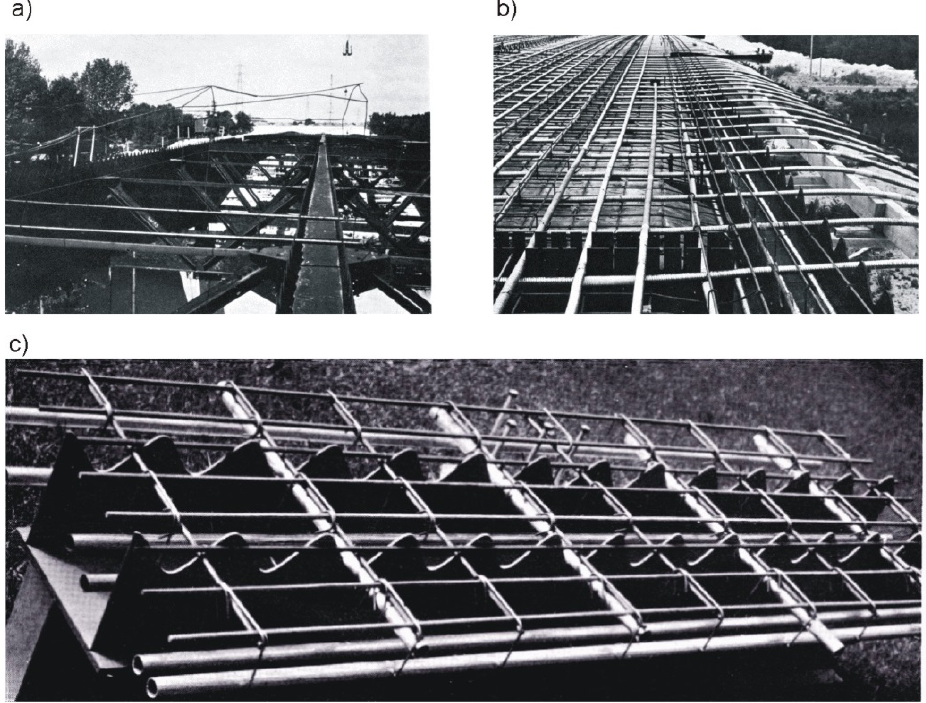
Figure 33: Girders of bridges with continuous shear connection based on friction: a) main girders with shear connection plates, b) transversal tendons, and c) beam specimen for tests (tests achieved in